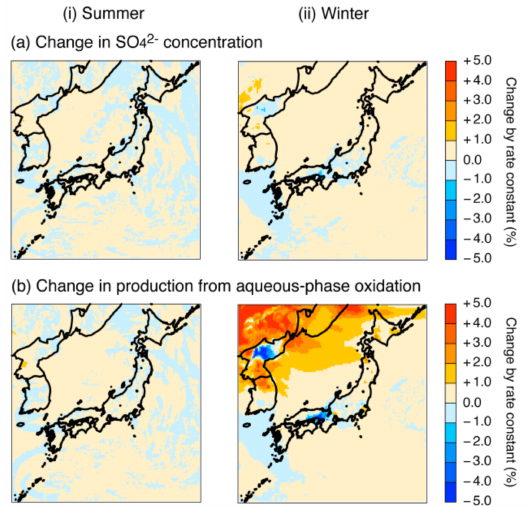
Figure 9. Changes in ( a ) SO 4 2 − concentration and ( b ) production from aqueous-phase oxidation averaged over ( i ) summer and ( ii ) winter. Model results from sensitivity simulation C are compared with sensitivity simulation B; therefore, the differences caused by the rate constant are